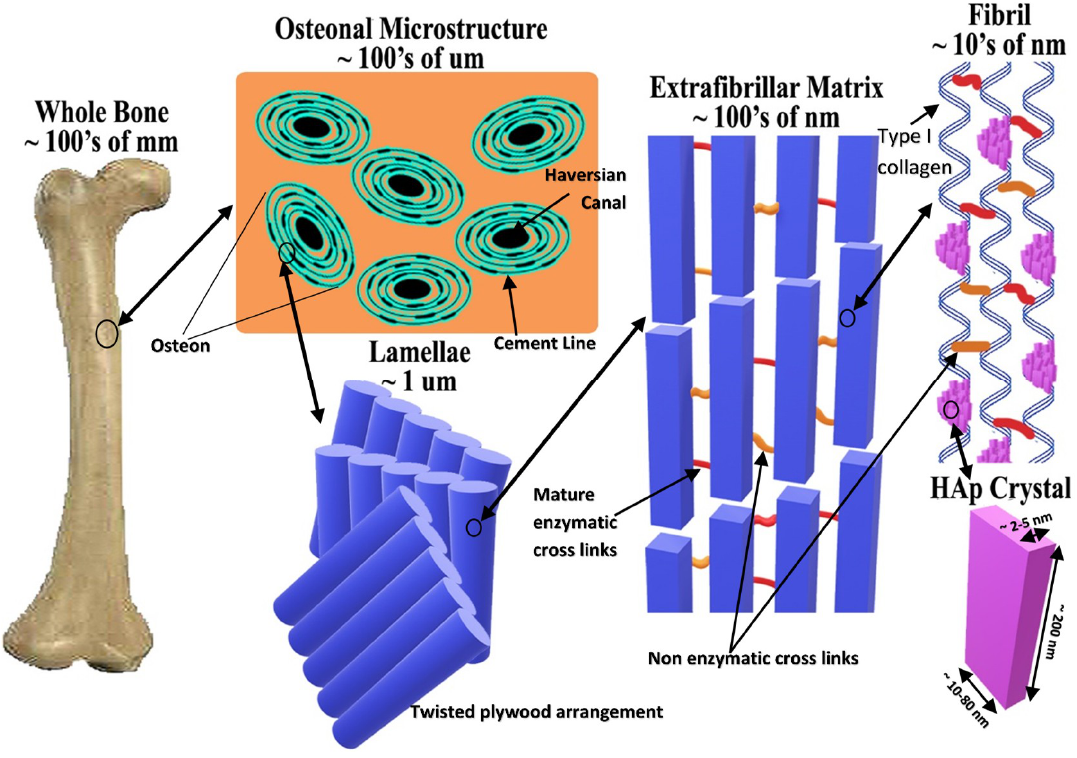
Figure 1. A microstructural representation of bone with size scales.